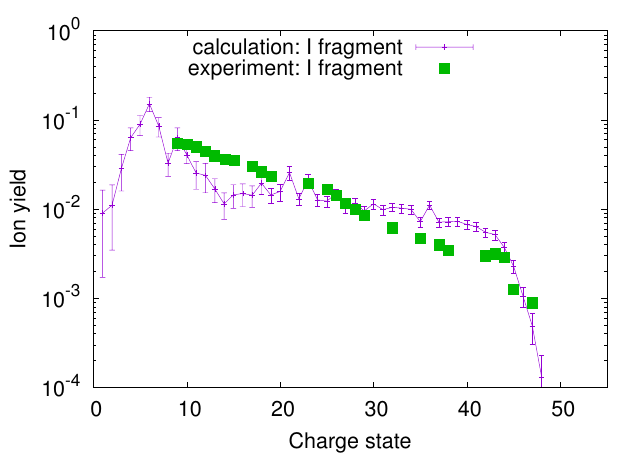
Figure 3. Distribution of iodine ions as a function of charge states. The green dots show experimental data points, whereas the pink curve show calcualted values. The error bars depict the standard error on the ion